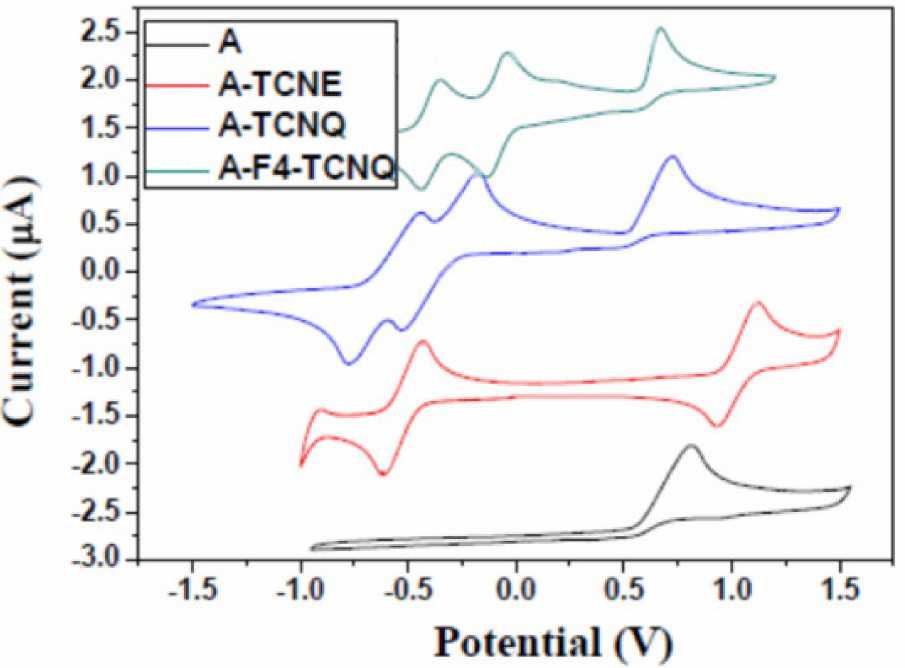
Figure 3. Cyclic voltammograms of all compounds in CH 2 Cl 2 with 0.1 M Bu 4 NPF 6 at rt, at a scanning rate of 0.1 V · S − 1 , with Ag/AgCl as the reference